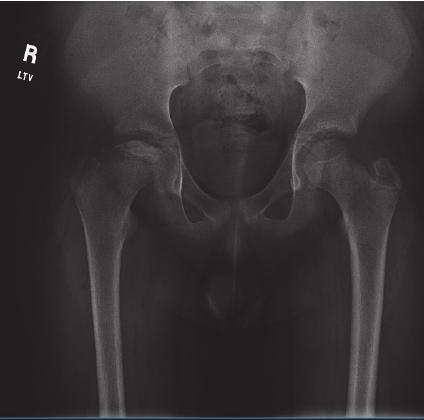
Figure 4: AP pelvis X-ray obtained 12 weeks from initial presen- tation with progressive flattening of femoral epiphysis indicative of segmental collapse seen in non-Perthes